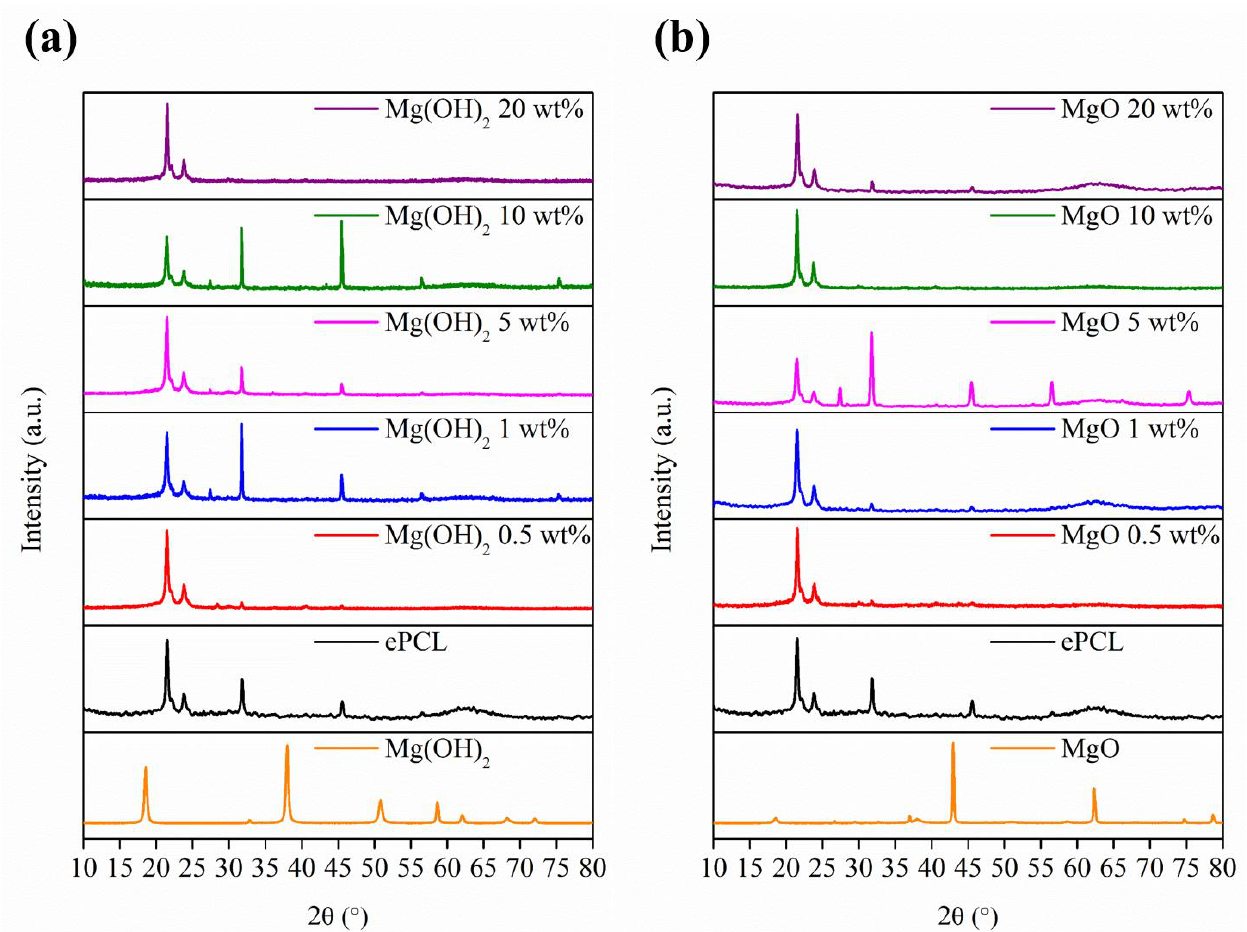
Figure 6. XRD analysis of ePCL reinforced with MgO NPs ( a ) and Mg(OH) 2 NPs ( b ) at